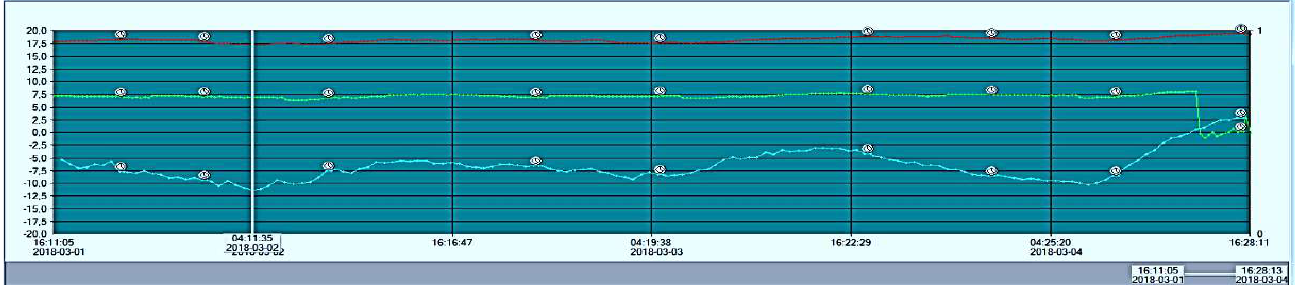
Figure 3. Groundwater temperatures chart at a depth of about 10 m.